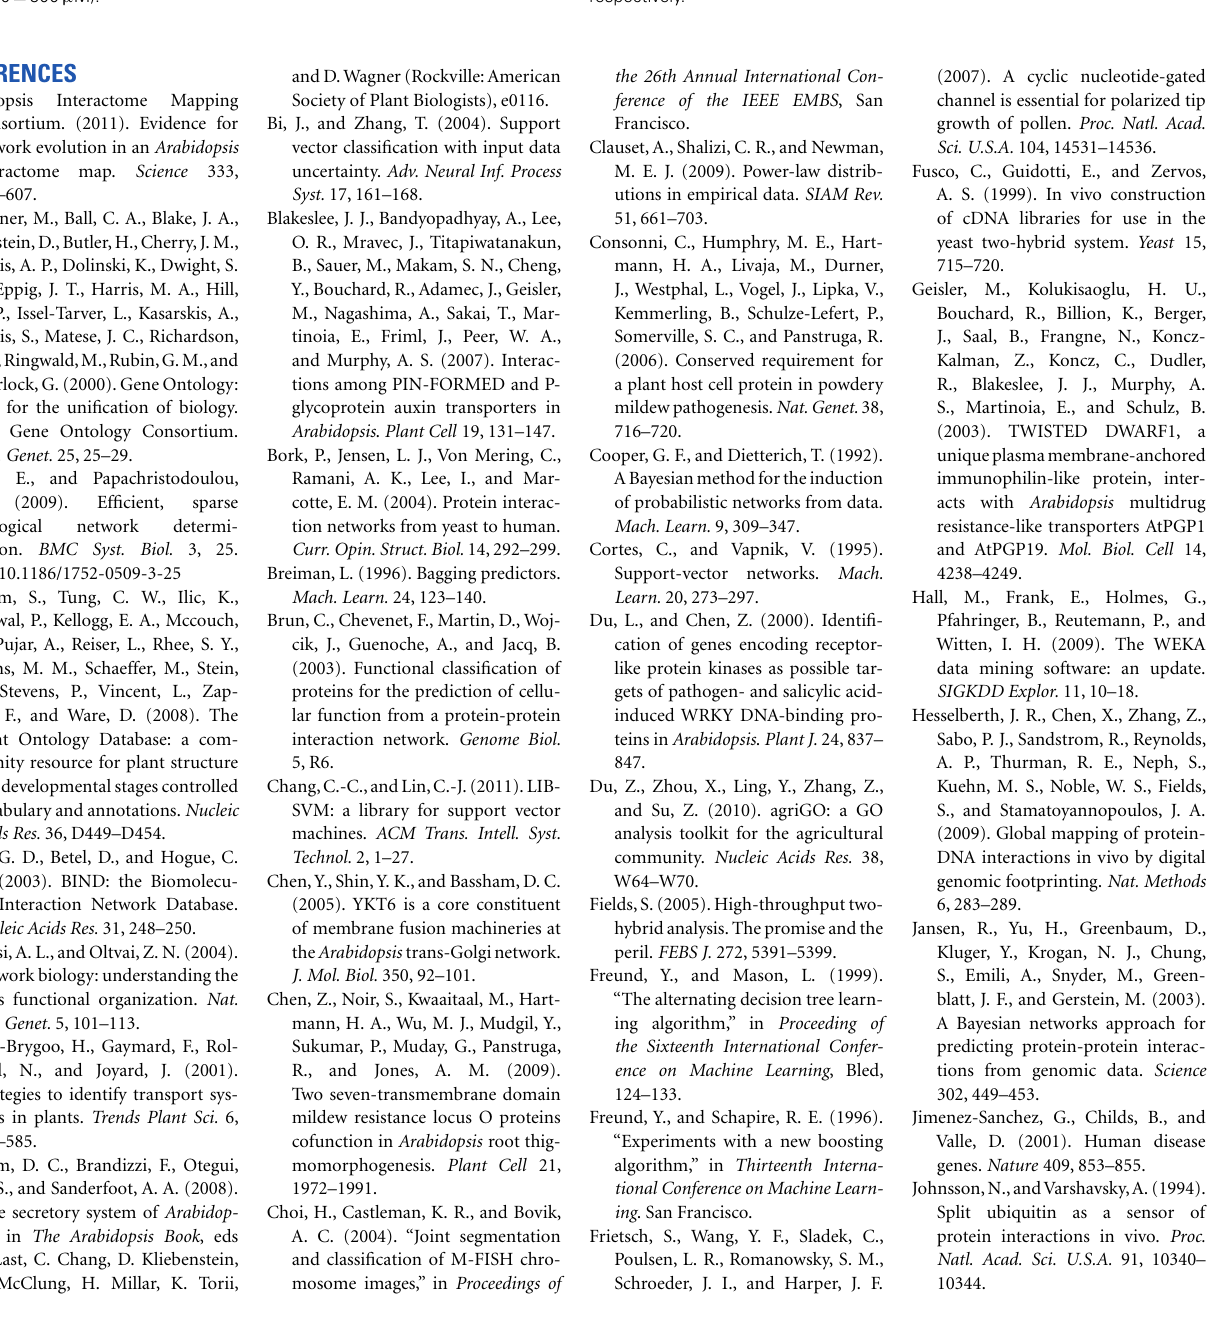
Figure S3 | Distribution of coefficient of variation of the replicates for the second mbSUS assays using LacZ reporter gene in different Figure S4 | Distribution of optical density of the interaction pairs in the second mbSUS assays based on the growth and LacZ reporter assays in different Figure S5 | Logistic regression of the probability of a true positive interaction on the statistical analysis of the first mbSUS runs. Histograms of the positive and negative data from the second mbSUS assay are shown on top and bottom,